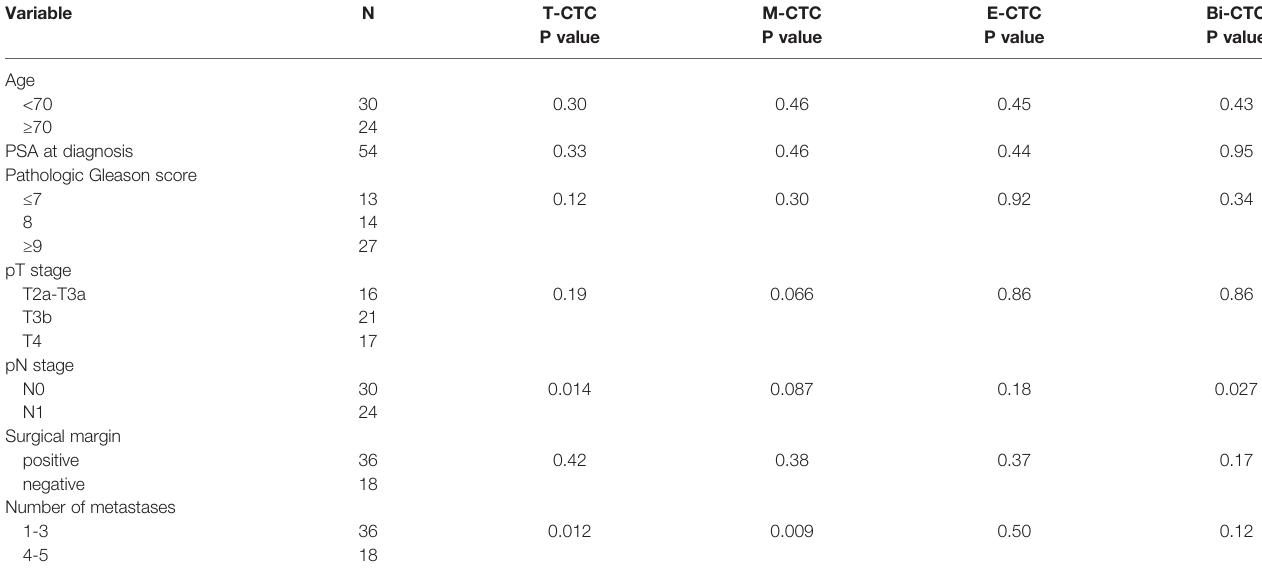
TABLE 2 | Correlation of CTC count and phenotype with clinicopathological variables.